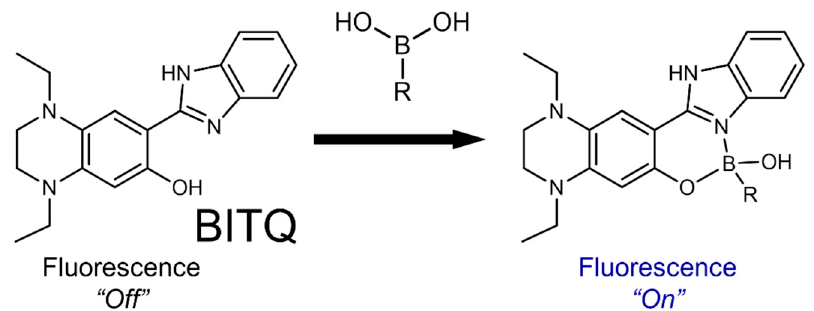
Figure 1. Schematic of boronic acid detection by formation of a fluorescent complex with BITQ.